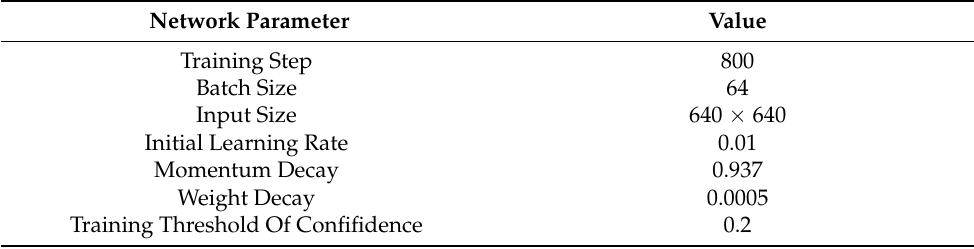
Table 2. List of training